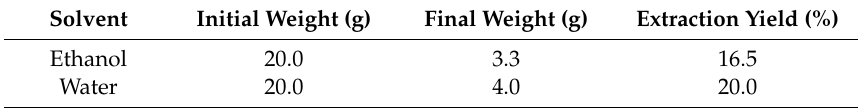
Table 2. Extraction yields of the E. camaldulensis crude extract with two di ff erent solvents.